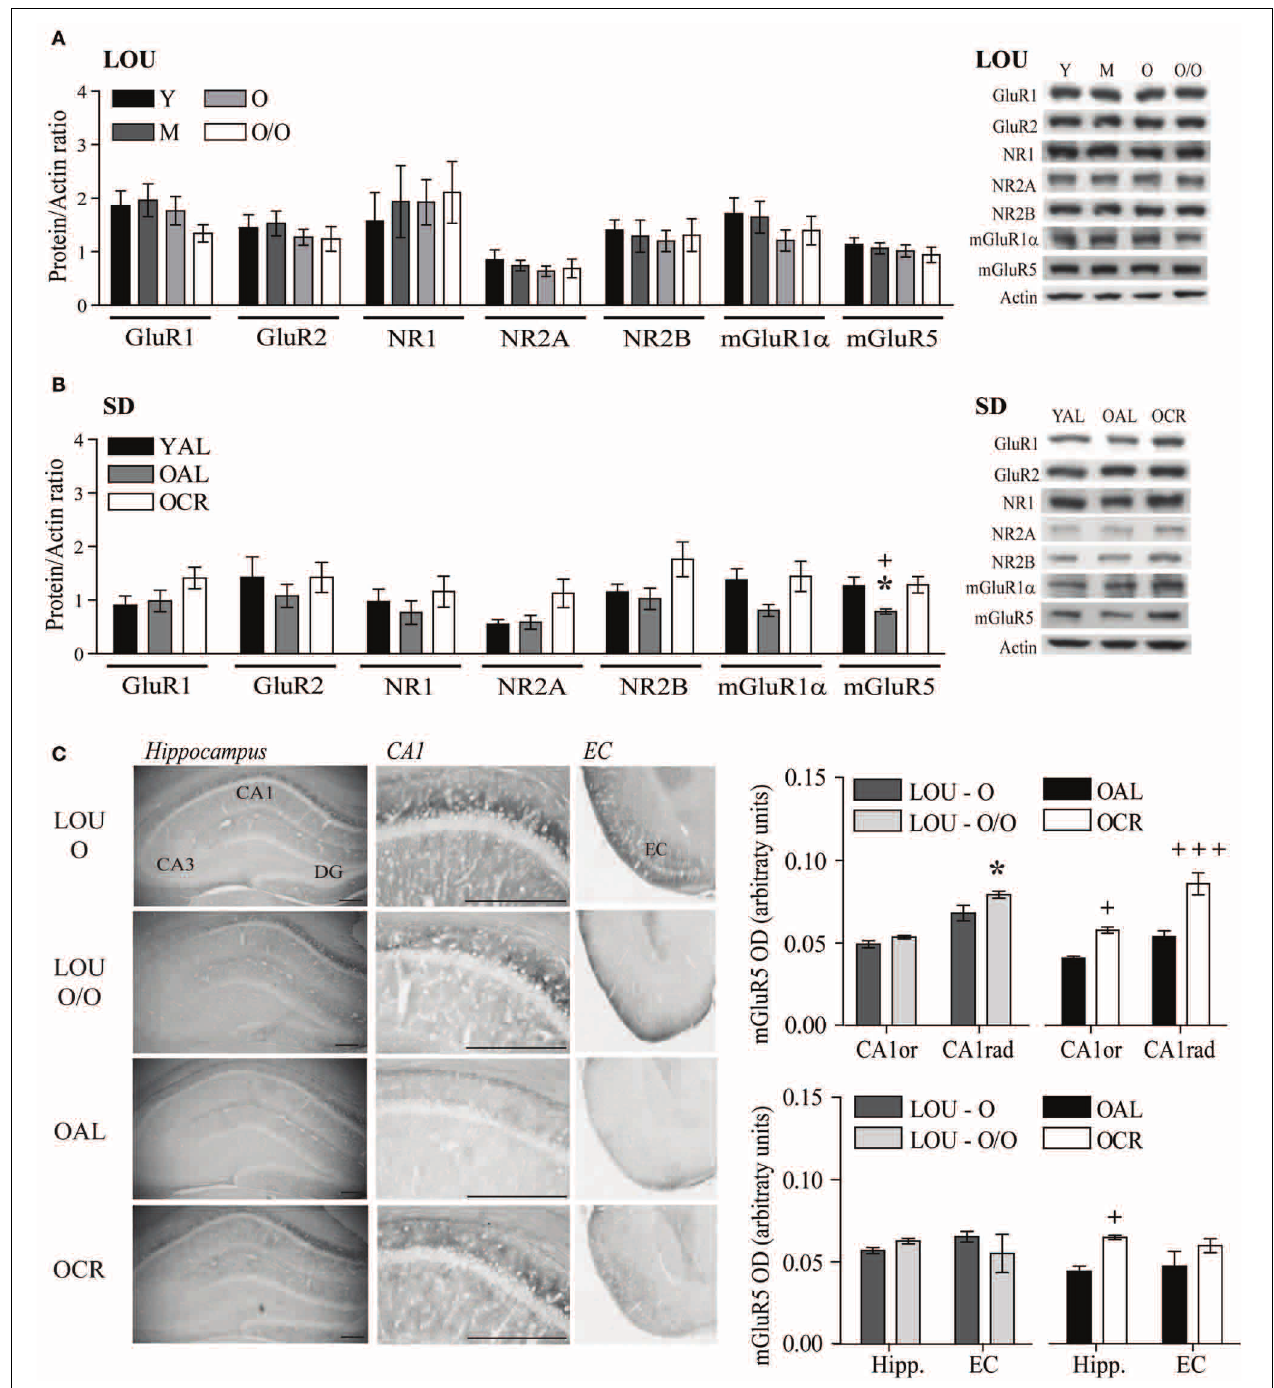
FIGURE 7 | Glutamate receptor levels are unaltered in aging LOU rats and mGluR5 expression is increased by LTCR in the hippocampus of old SD rats. (A) No change for ionotropic AMPA GluR1, GluR2, NMDA NR1, NR2A, NR2B, and metabotropic mGluR1 α and mGluR5 protein level was observed in LOU rat hippocampal formation up to 38–42 months of age. (B) mGluR5 receptor level was significantly reduced in OAL compared to young and